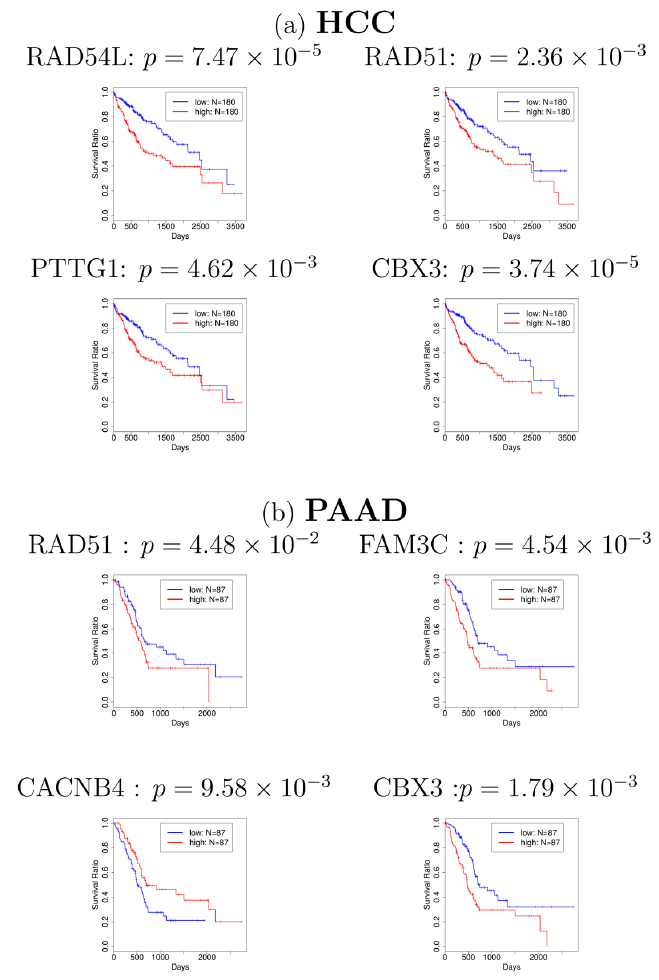
Figure 2. Kaplan–Meier plots for ( a ) hepatocellular carcinoma (HCC) and ( b ) pancreatic adenocarcinoma (PAAD). Blue: patients with lower gene expression (lower half, N = 180 for HCC, N = 87 for PAAD). Red: patients with higher gene expression (upper half, N = 180 for HCC, N = 87 for PAAD). Most of the figures show that patients with lower gene expression (blue line) have a higher survival probability.